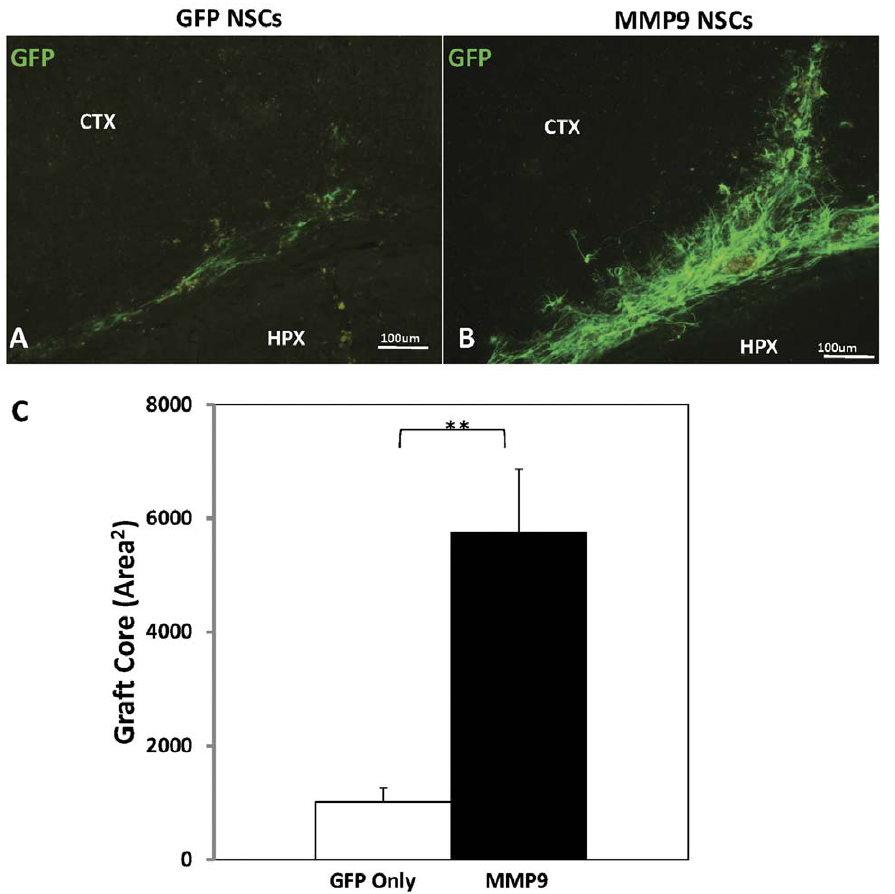
Figure 5. NSC engraftment is enhanced by MMP9 overexpression. MMP9-NSC grafts (n=5) were larger than GFP-NSC grafts (n=4) in APPswe/PS1dE9 mice (A–B). Aggregate data on the area of GFP immunoreactivity in sections with evidence of needle track penetration indicated grafts were 82.4% larger for MMP9-NSCs compared to those expressing only GFP (C). **p , 0.01.